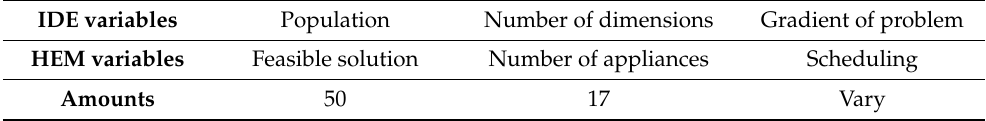
Table 1. IDE mapping on HEM. IDE variables Population Number of dimensions Gradient of problem HEM variables Feasible solution Number of appliances Scheduling Amounts 50